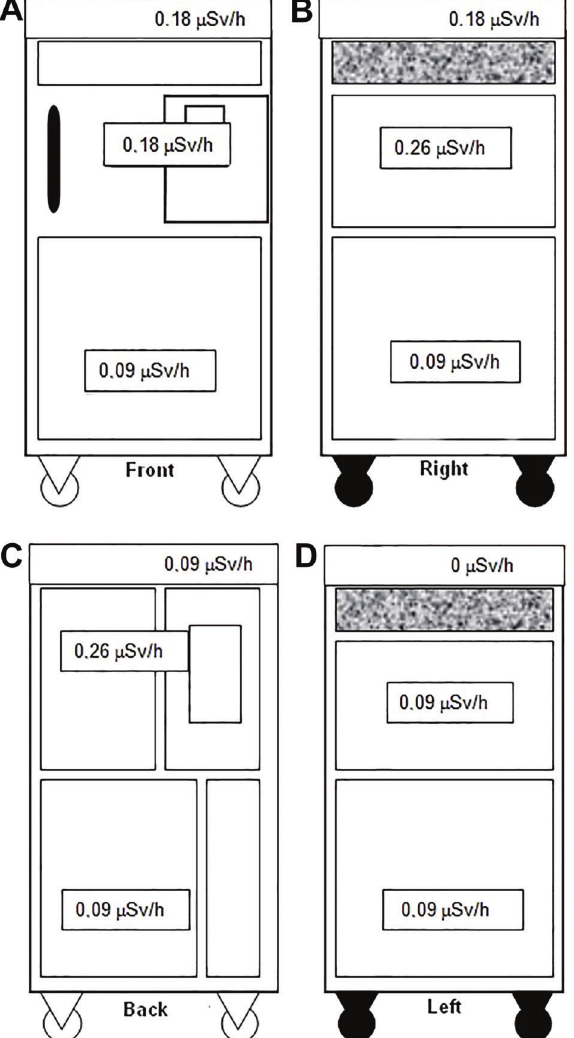
Figure 8. Relationship between dose rate and tube current (default position).